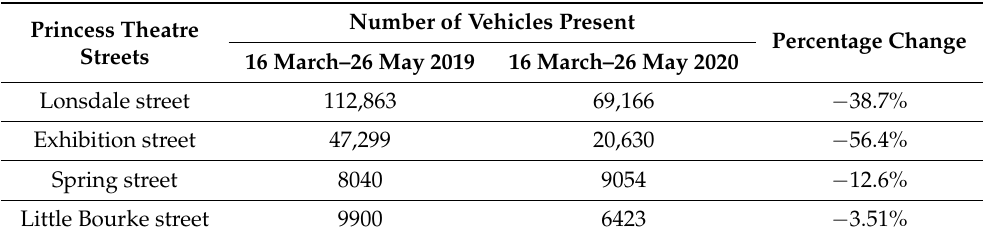
Table 5. Street level comparisons of the parking volume in terms of the change in number of vehicles